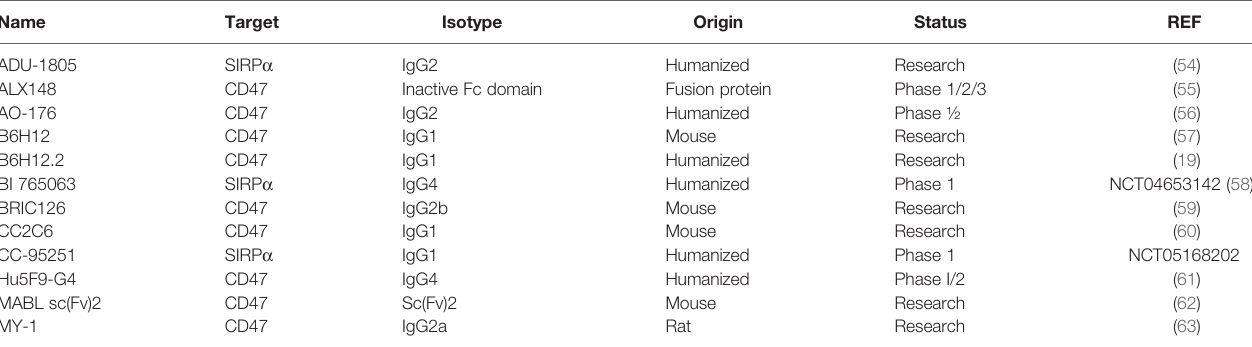
TABLE 1 | The characteristics of anti-human CD47/SIRP a antibodies and